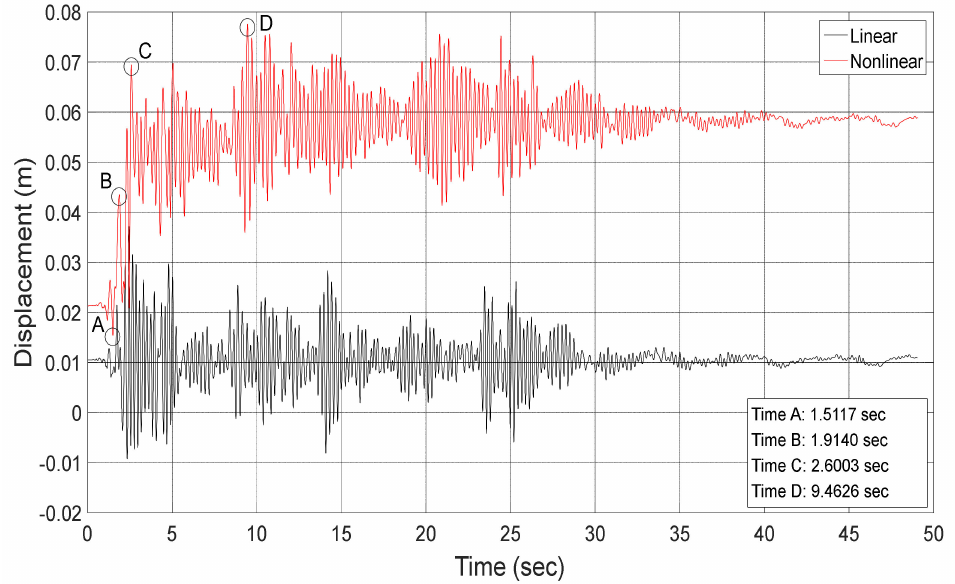
Figure 3. Input ground motion: ( a ) Time histories of the components corresponding V/H ratios.